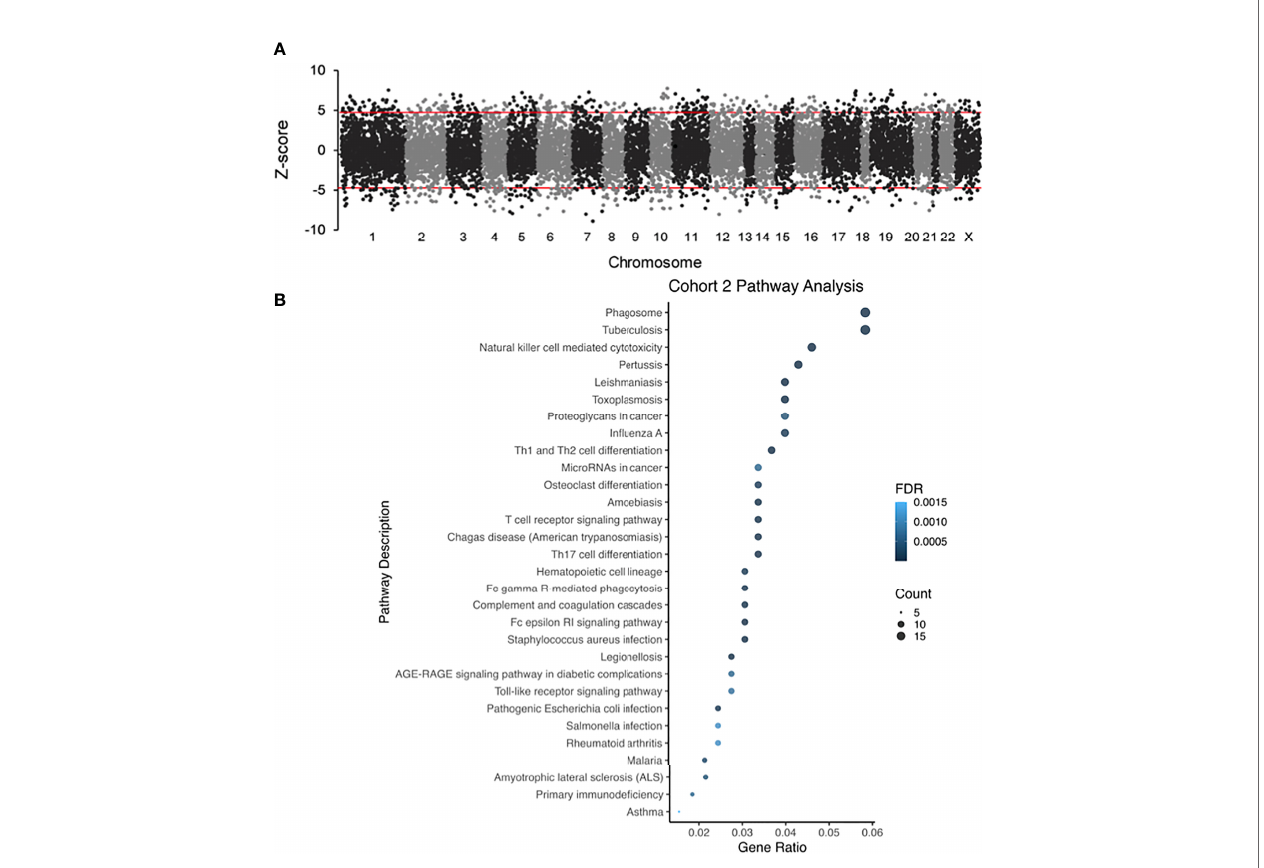
FIGURE 3 | (A) Different glomerular microarray platforms in GEO were converted to Entrez Gene identi fi ers and analyzed by eGWAS (Cohort 2). Using a one-tailed T-test P values between DKD and controls were calculated, which were converted to Z-scores and meta-analysis was performed based on the weighted Z-method. Gene expression leading to a Z-score above 5 or below -5 was considered signi fi cantly up or downregulated. (B) Dot-plot showing the top pathways in cohort